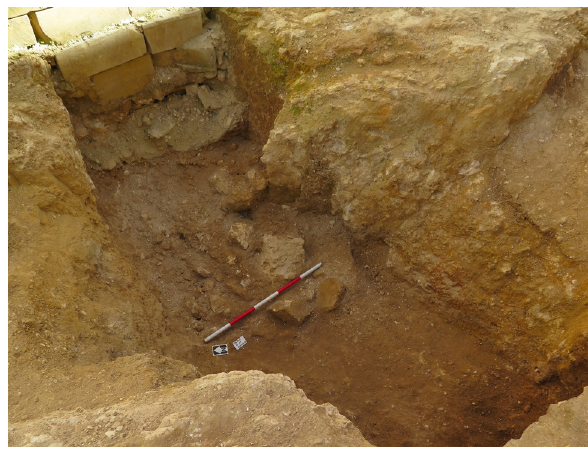
Figure 14: General view of the central part of the chamber, the shaft and the third - party wall partially blocking the